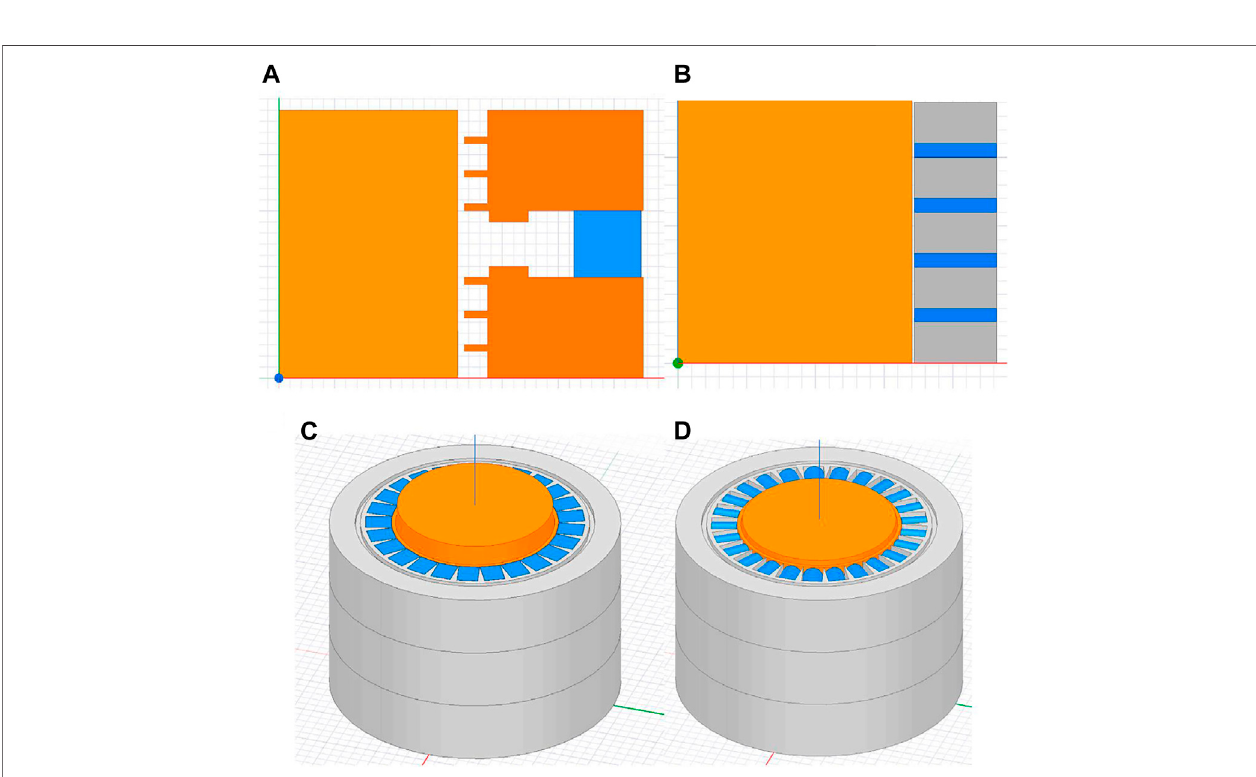
Modeling and Simulation For the classic FF seal and FF radial-charged seal, we used SolidWorks to draw the core of the sealing device of the